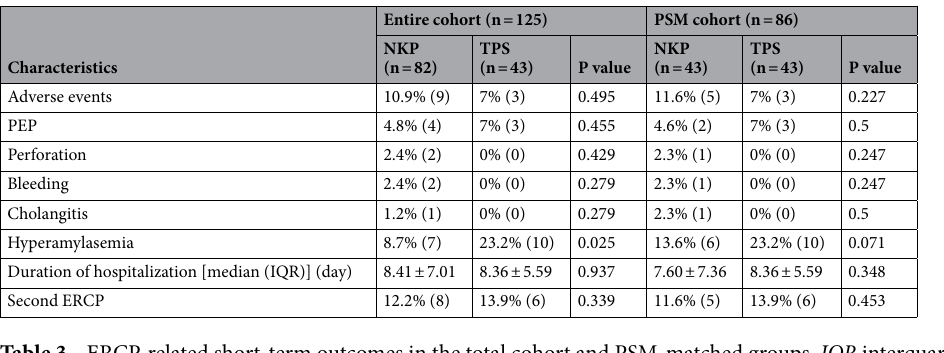
Table 3. ERCP-related short-term outcomes in the total cohort and PSM-matched groups. IQR interquartile range.